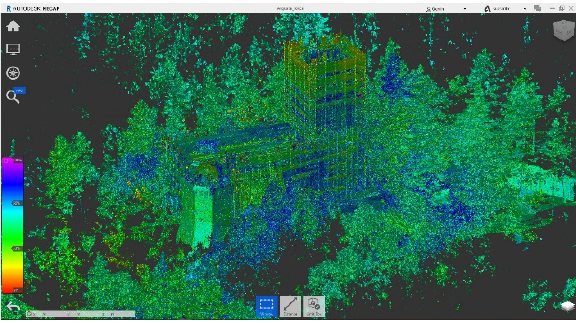
Figure 6. Point cloud